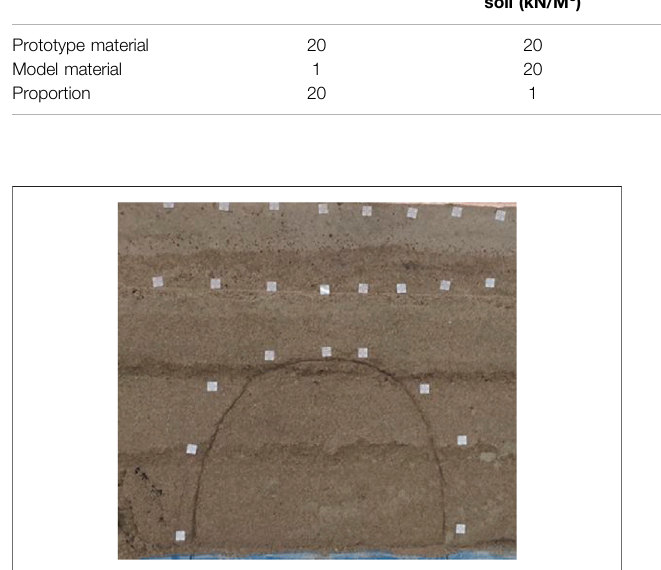
FIGURE 4 | Real picture of tunnel collapse and even surface collapse.